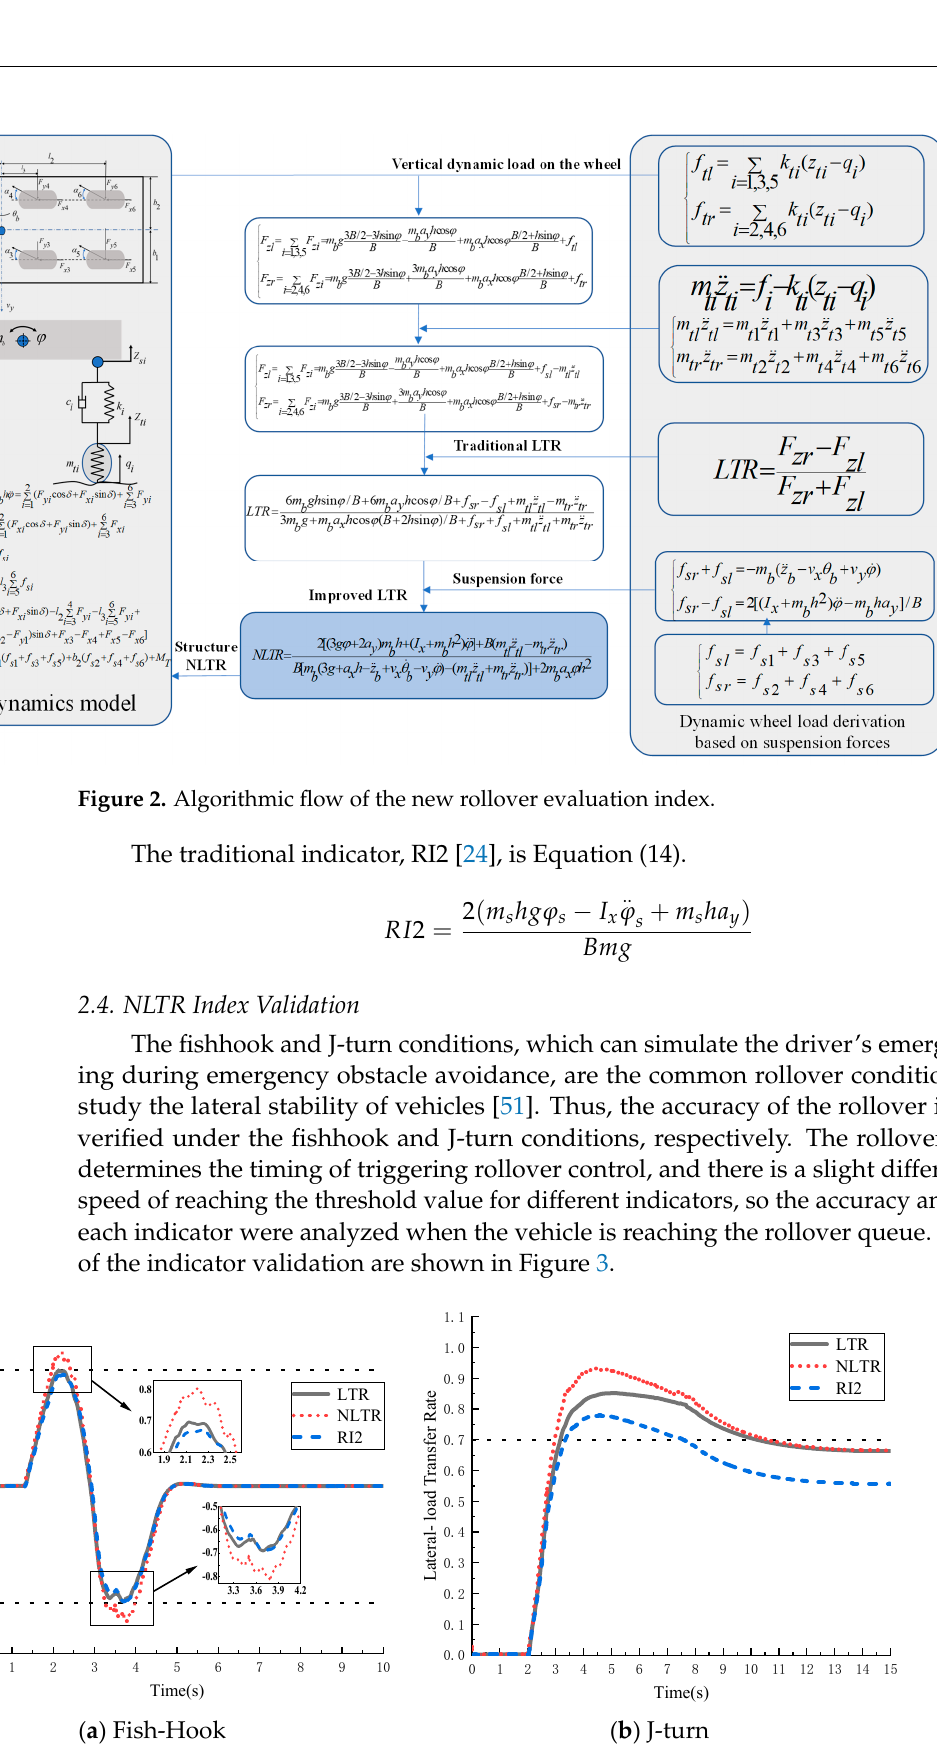
Figure 3. Comparison of three types of rollover indicators in time domain. In Figure 3, the horizontal dashed line represents the vehicle rollover queue value. In order to further verify the applicability of NLTR indicators, the vehicle’s speed was set to 40, 60 or 80km/h, and the maximum values and trends of different indicators are com- pared. The results are shown in Figure 4.